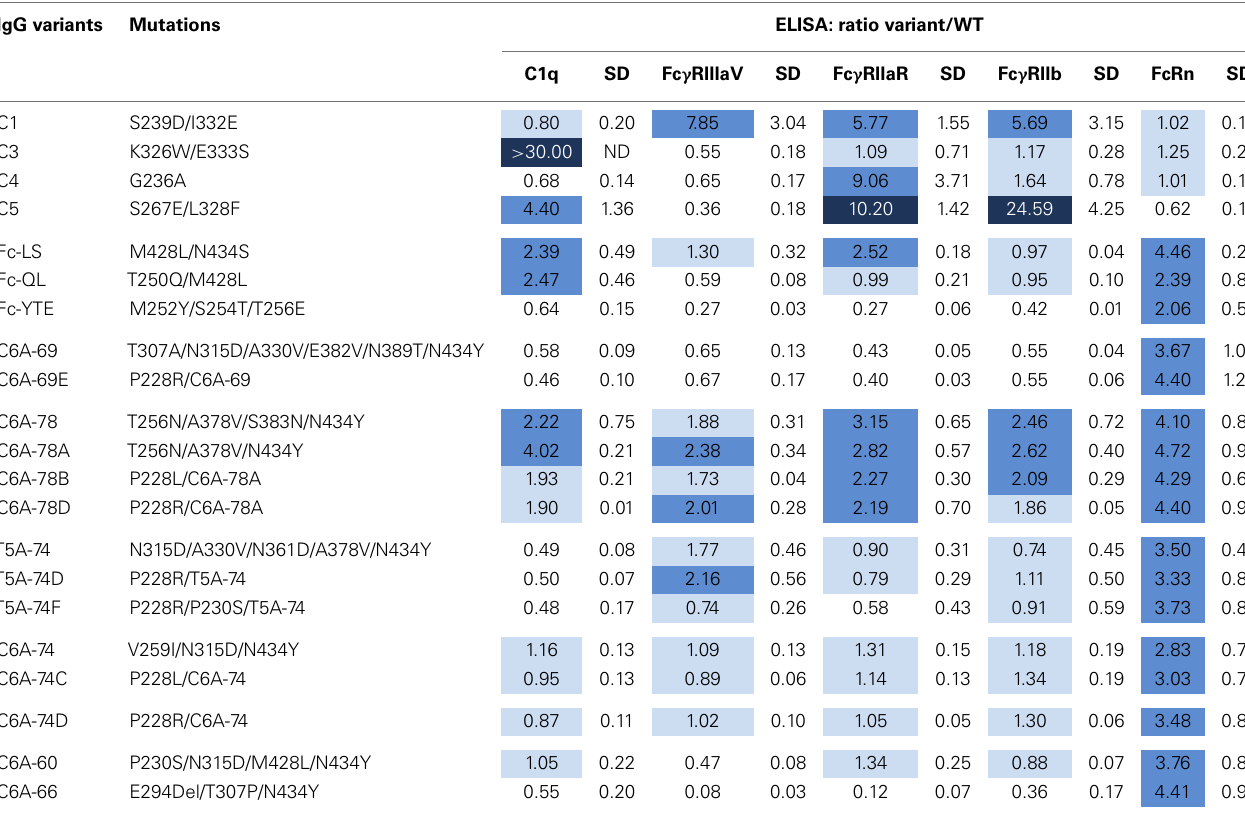
Table 6 | Binding cartography of IgG variants produced in HEK293 cells on the complement C1q, Fc γ RIIIA-V158, Fc γ RIIA-R131, Fc γ RIIB, and FcRn . IgG variants